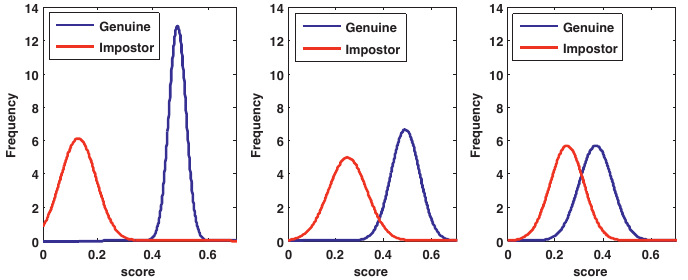
Figure 4. Genuine and impostor similarity matching score distributions of three matchers: strong matcher (left), medium matcher (middle) and weak matcher (right).